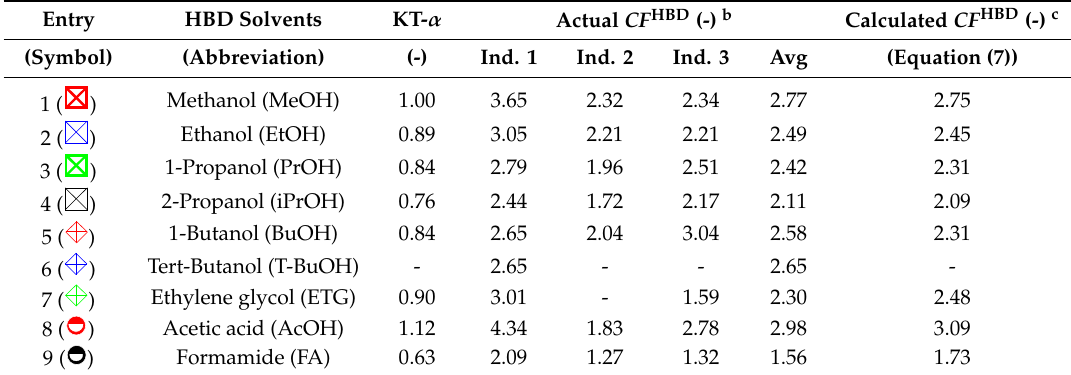
a Indicators: Ind. 1 = 2,6-diphenyl-4-(2,4,6-triphenyl-1-pyridinio) phenolate indicator; Ind. 2 = phenol blue and Ind. 3 = Nile red. b Actual CF HBD values are evaluated from Figure 2. c Calculated CF HBD values are obtained from Equation (7).